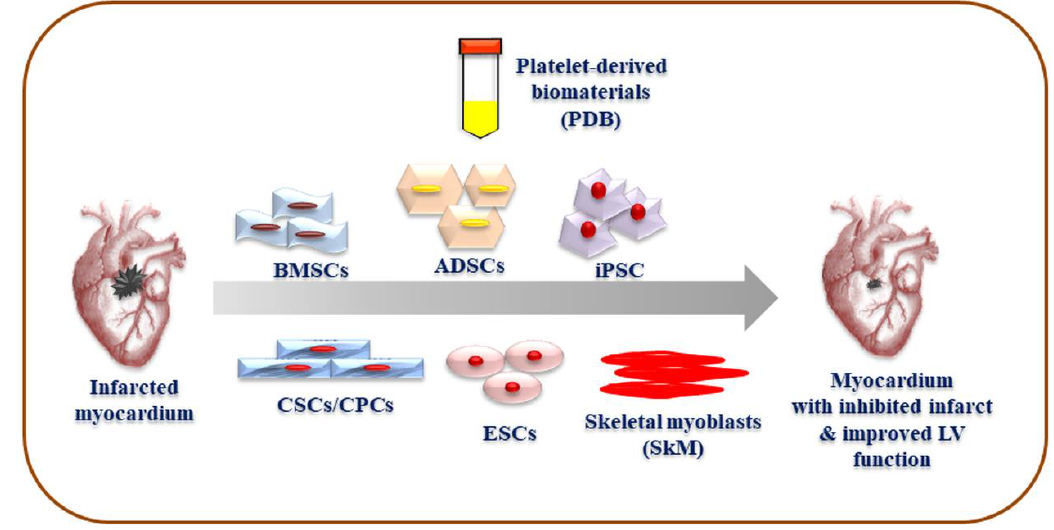
Figure 3. Stem cell and platelet-derived biomaterials-based bioengineering of infarcted myocardium. ADSCs: Adipose-derived stem cells, BMSCs: Bone marrow-derived stem cells, CPCs: Cardiac progenitor cells, CSCs: Cardiac stem cells, ESCs: Embryonic stem cells, iPSC: Induced pluripotent stem cells, LV: left ventricular, PDB: Platelet derived biomaterials, SkM: Skeletal myoblasts. These therapies aim to inhibit infarct regions and improve left ventricular function for successful cardiac recovery.